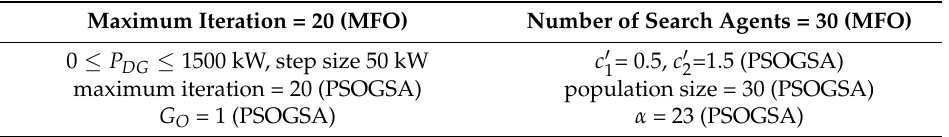
Table 1. The definition of used